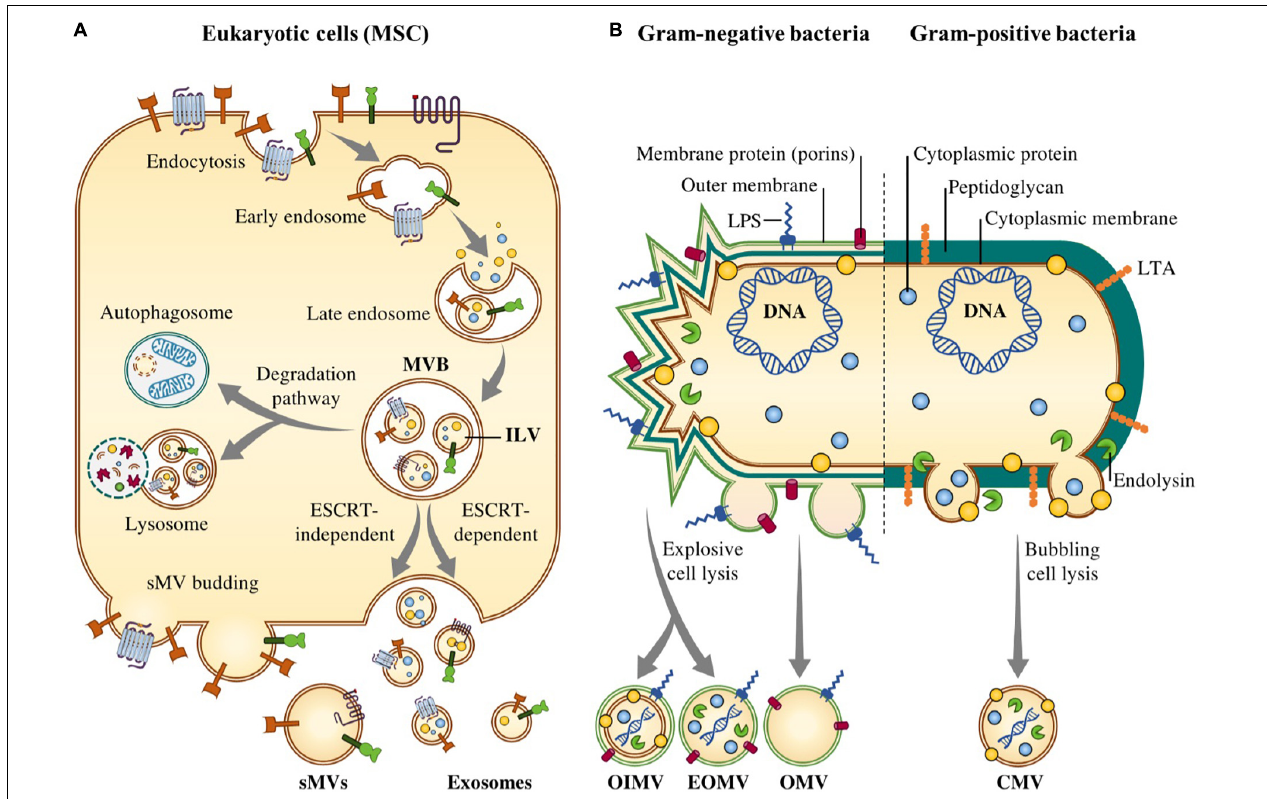
FIGURE 1 | Biogenesis of Extracellular vesicles (EVs) in eukaryotic cells and Gram-negative and –positive bacteria. (A) In eukaryotic cells, biogenesis of EVs consists of three consecutive steps, including (i) formation of early endosome by invagination of the plasma membrane; (ii) formation of late endosome and then MVBs; and finally (iii) fusion of MVBs with the plasma membrane and release of the vesicular contents by ESCRT-dependent and –independent mechanisms. (B) In the Gram-negative bacterial extracellular vesicles, known as outer membrane vesicles mainly originate from the outer membrane of bacterial envelope. Three potential biogenesis mechanisms have been suggested including the blebbing of the outer membrane of the bacterial envelope (OMVs), the formation of outer-inner membrane vesicles (OIMVs) and the formation of explosive outer membrane vesicles (EOMVs). Gram-positive bacteria (B) lack an outer membrane and also have a thick peptidoglycan cell wall outside of the cell membrane which convey the assumption that membrane-derived vesicles could not escape such large barriers but EVs may be forced through the wall by turgor pressure after release from the plasma membrane. In addition, cell wall-modifying enzymes facilitate the released of